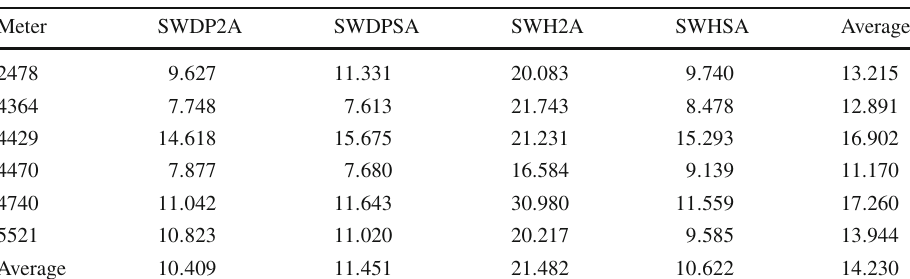
Table 3 ANOVA comparison of meters